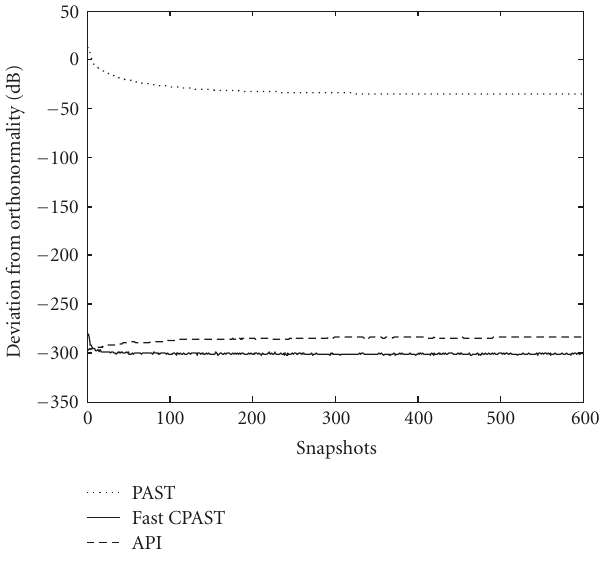
Figure 7: Deviation from orthonormality for three algorithms in the third